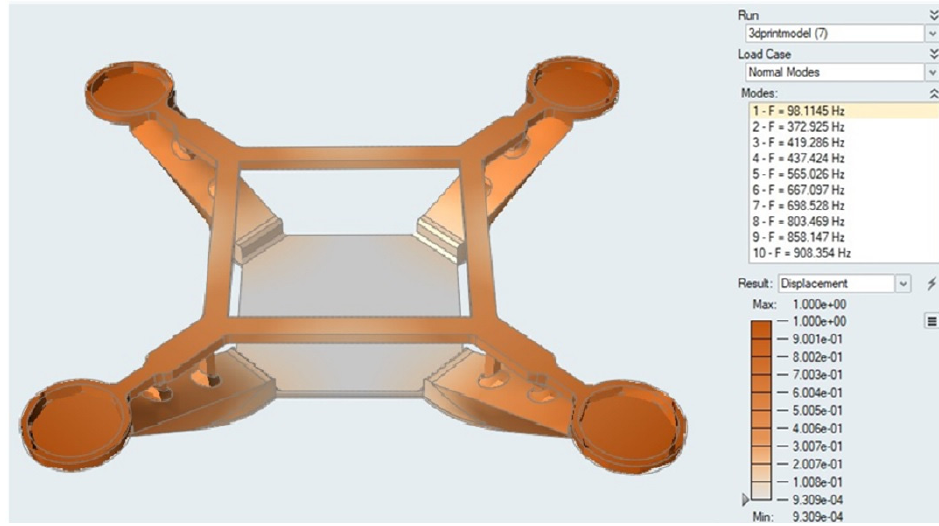
Figure 13. Modal analysis.